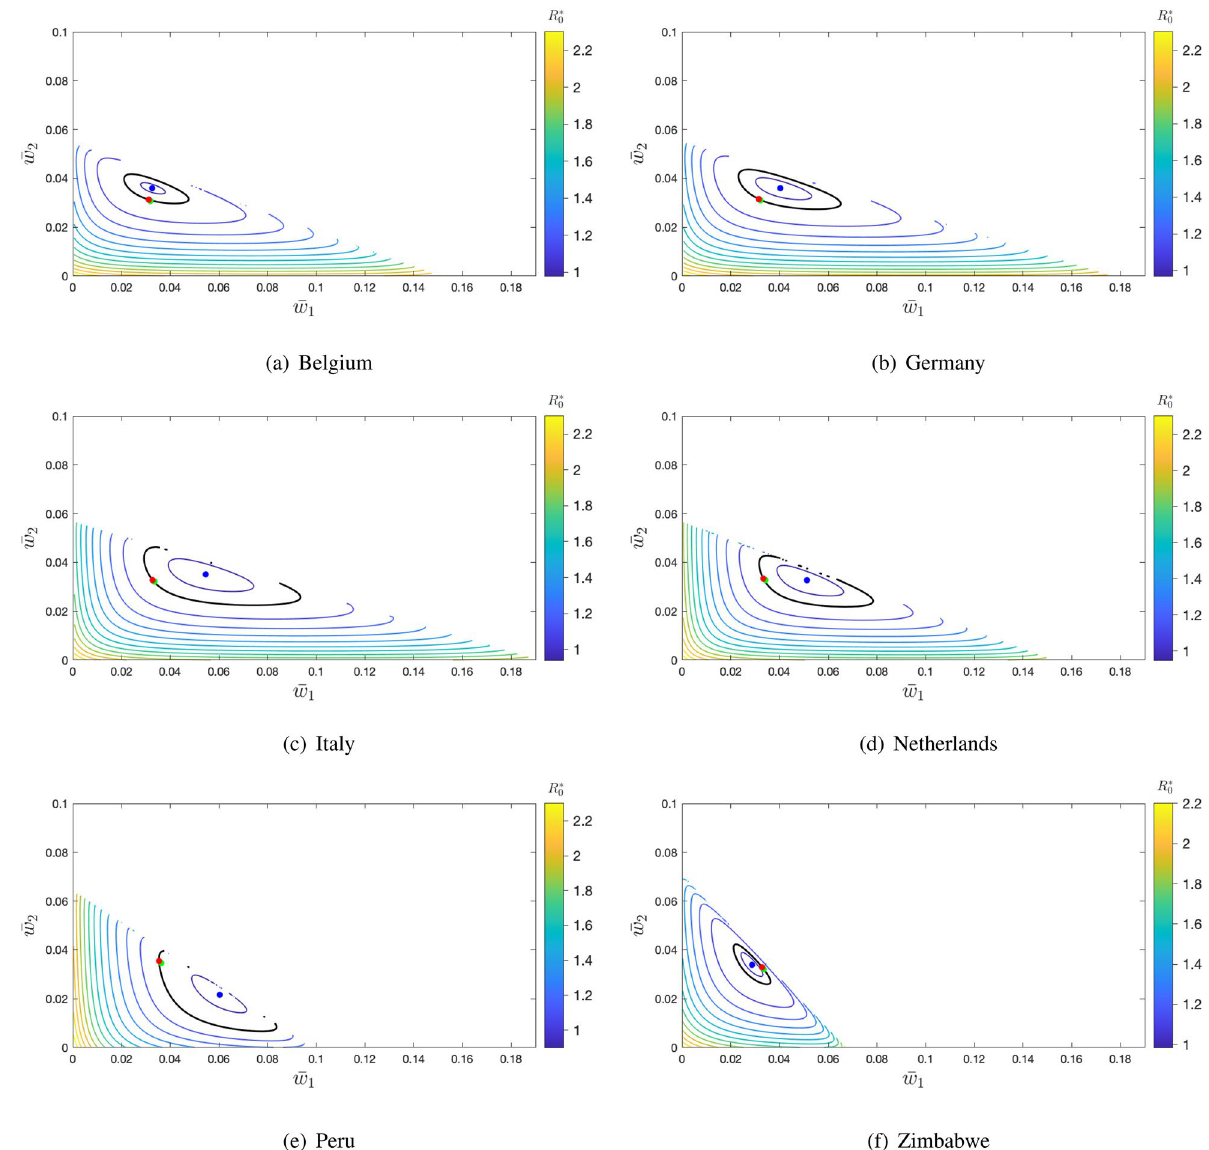
Figure 3. Contour levels of R ∗ 0 ( ¯ w 1 , ¯ w 2 ) at the DFE of system (1) with p i = 1 ( i = 1, 2, 3 ). Black level curve corresponds to R ∗ 0 = 1 . Blue point: Minimum of R ∗ 0 . Red point: R ∗ 0 under uniformly random vaccination ( ¯ w 1 = ¯ w 2 = ¯ w c ). Green point: R ∗ 0 at the disease-free equilibrium with the maximum vaccination coverage. Parameters: γ 1 = 1 , γ 2 = 1 , γ 3 = 0.9 , δ v 1 = 1 / 40 , δ v 2 = 1 / 52 , δ v 3 = 1 / 40 , and ¯ w = ¯ w c for each data set. For each country, β is scaled such that R 0 = 2.5 in the absence of vaccinated